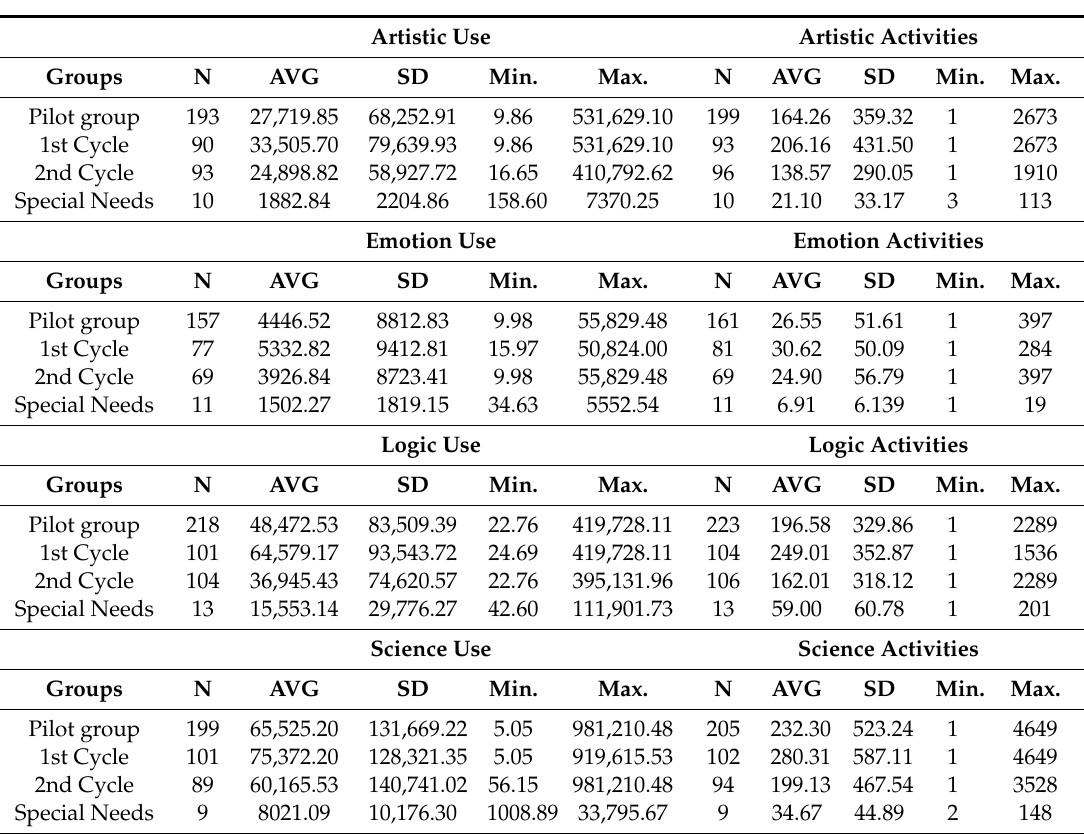
Table A3. Descriptive statistics of the Pilot Group 2 at platform worlds. The use is measured in seconds and the activities done are collected as